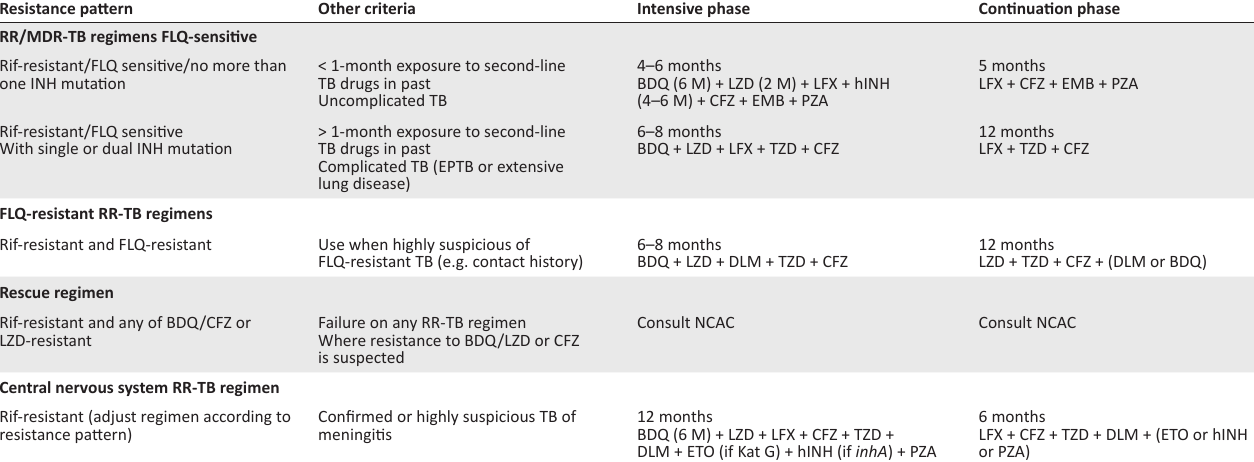
TABLE 1: Updated drug-resistant tuberculosis regimens for adults and adolescents. Resistance